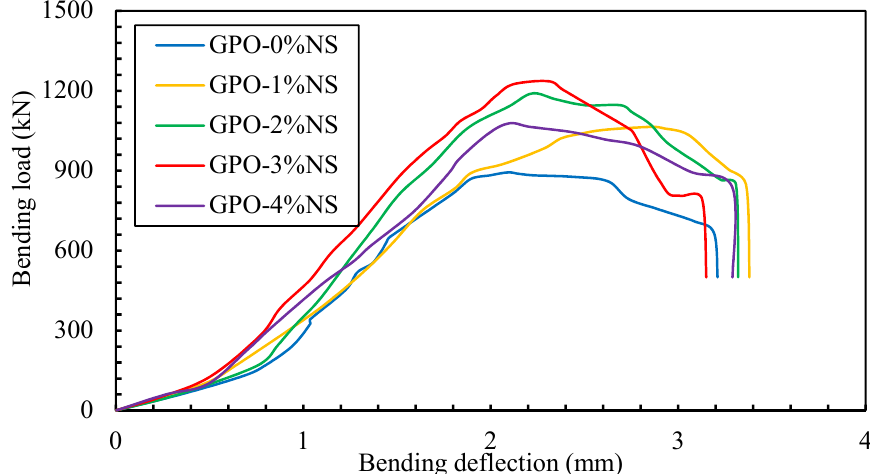
Figure 13. Load–mid span deflection curves of carbon-fiber-reinforced GPO samples.